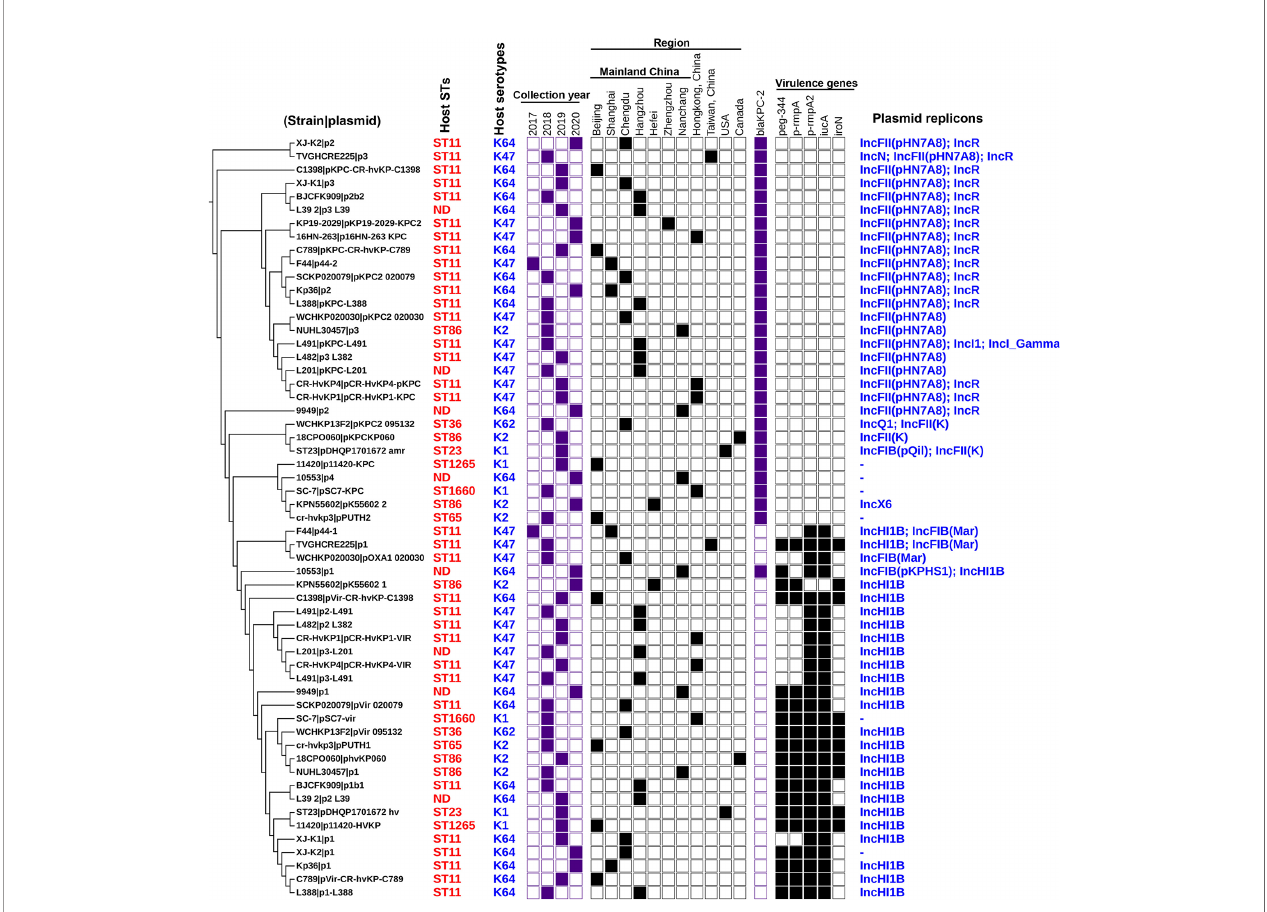
FIGURE 8 | Details for the characteristics of the 57 antibiotic-resistance or virulence plasmids carried by the 29 Hv- bla KPC (+)-KP strains. The phylogenetic patterns were based on the presence/absence of orthologous gene families of 57 plasmids under analysis. Seven categories of information were presented in this fi gure, including the phylogenetic tree of 57 plasmids, STs of host strains, collection year, collection region, bla KPC-2 gene, core virulence genes and replicon types of plasmids. ND, not de fi ned. The presence of genes, etc. is represented by a solid box and the absence of others is represented by a white